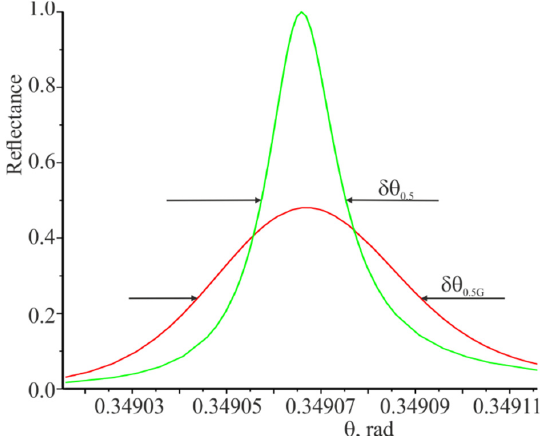
Figure 4. Angular dependences of the reflection coefficient at the incidence of the plane wave and the Gaussian beam on the grating. The green curve is the incidence of the plane wave on the grat- ing. The red curve is the incidence of the Gaussian beam at 𝐿 = 20 mm,𝑛 (cid:3040) = 0.025 . The resonant wavelength is 1.064 μm .